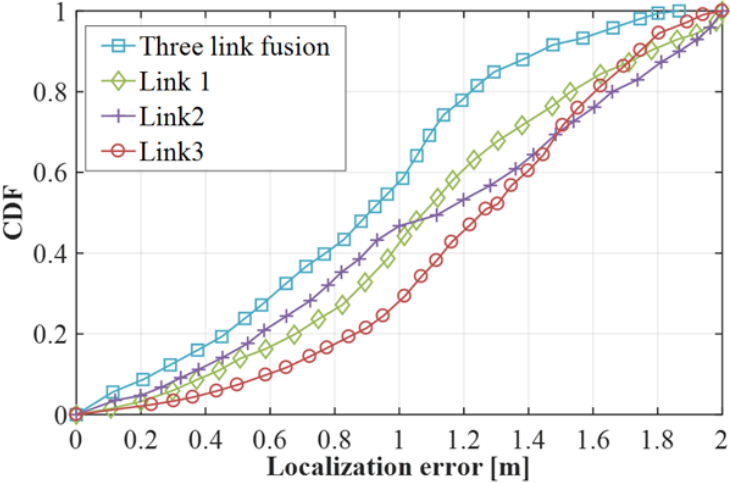
Figure 9. Performance comparison between single link and combined